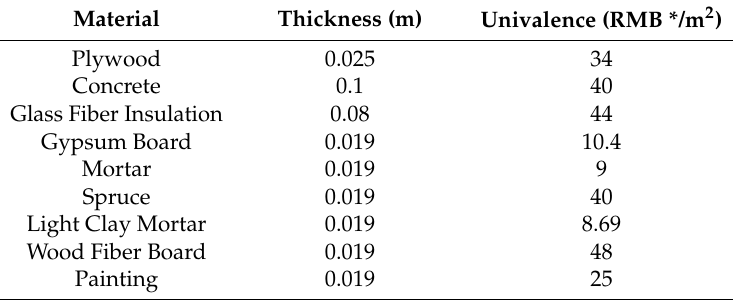
Table 3. The univalence of materials.